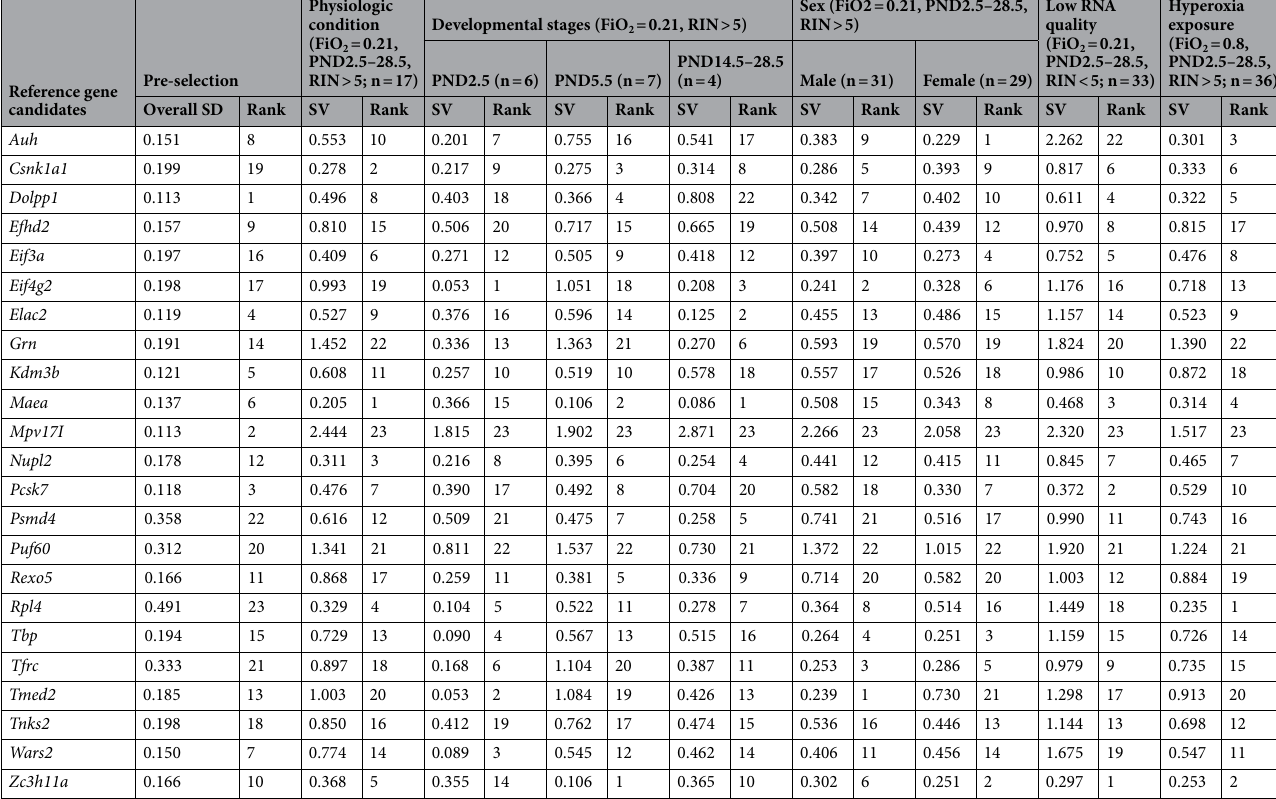
Table 3. Normfinder result represented with SV-values and corresponding stability ranking for different analytic approaches compared with the